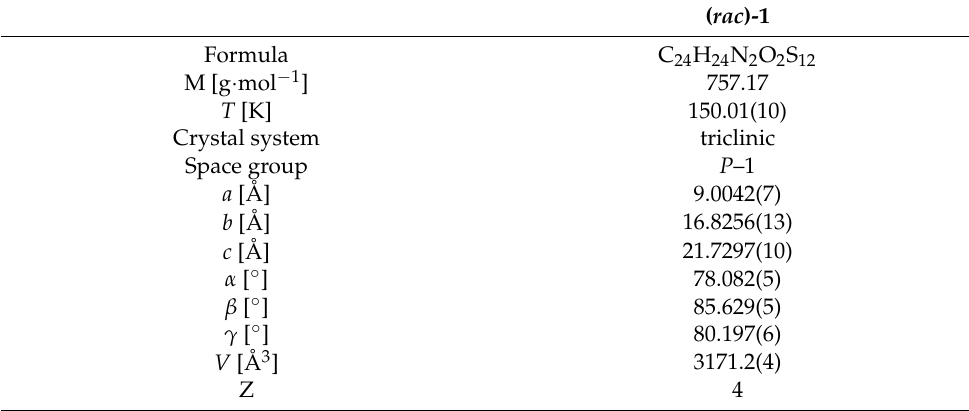
Table 1. Crystallographic data, details of data collection and structure refinement parameters for compound ( rac )- 1